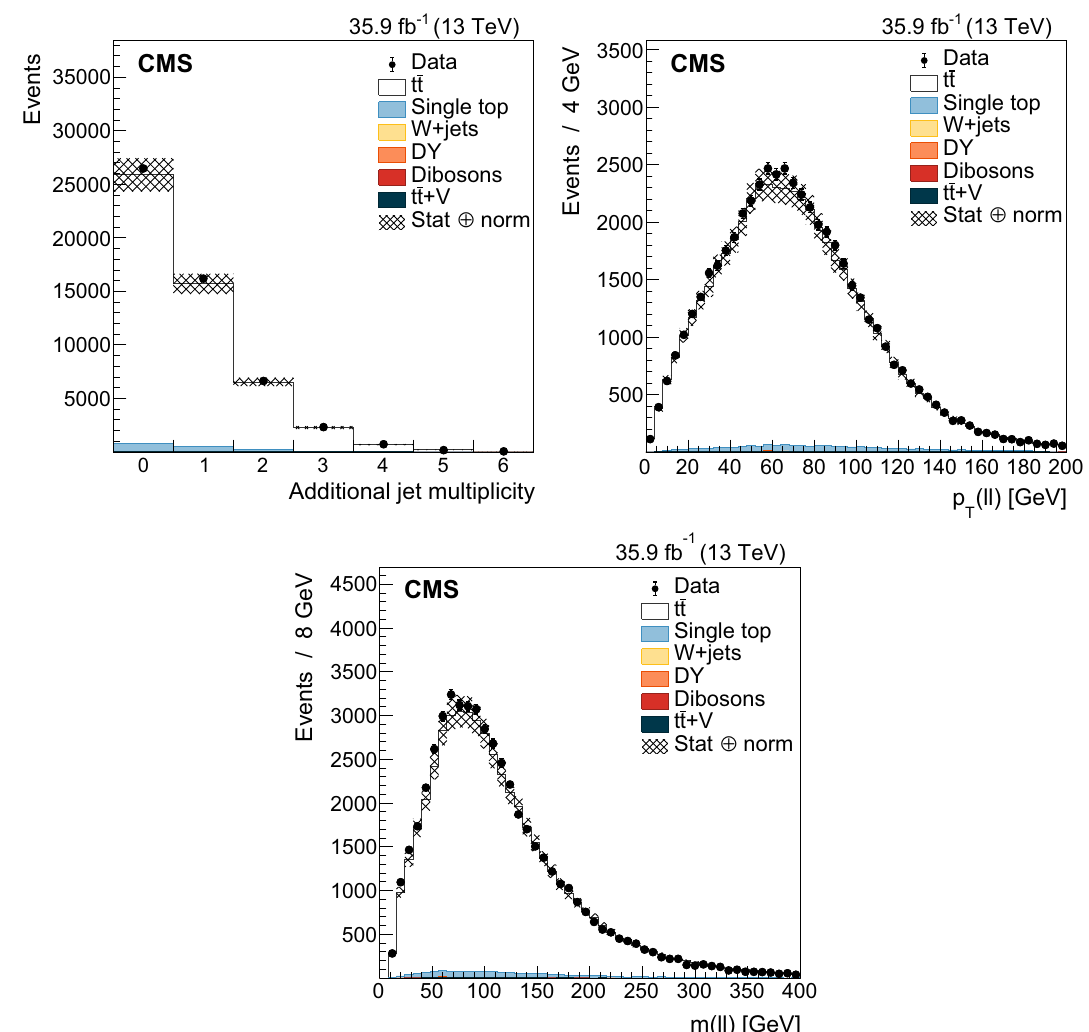
Fig. 2 Distributions of the variables used to categorize the study of the UE. Upper left: multiplicity of additional jets ( p T > 30 GeV). Upper right: p T ((cid:6)(cid:6)) . Lower: m ((cid:6)(cid:6)) . The distributions in data are compared to